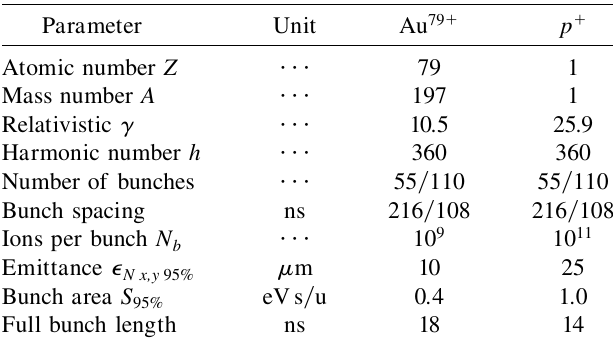
TABLE I. Machine and beam parameters for gold and pro- tons during RHIC Run 2001 = 2002 , at